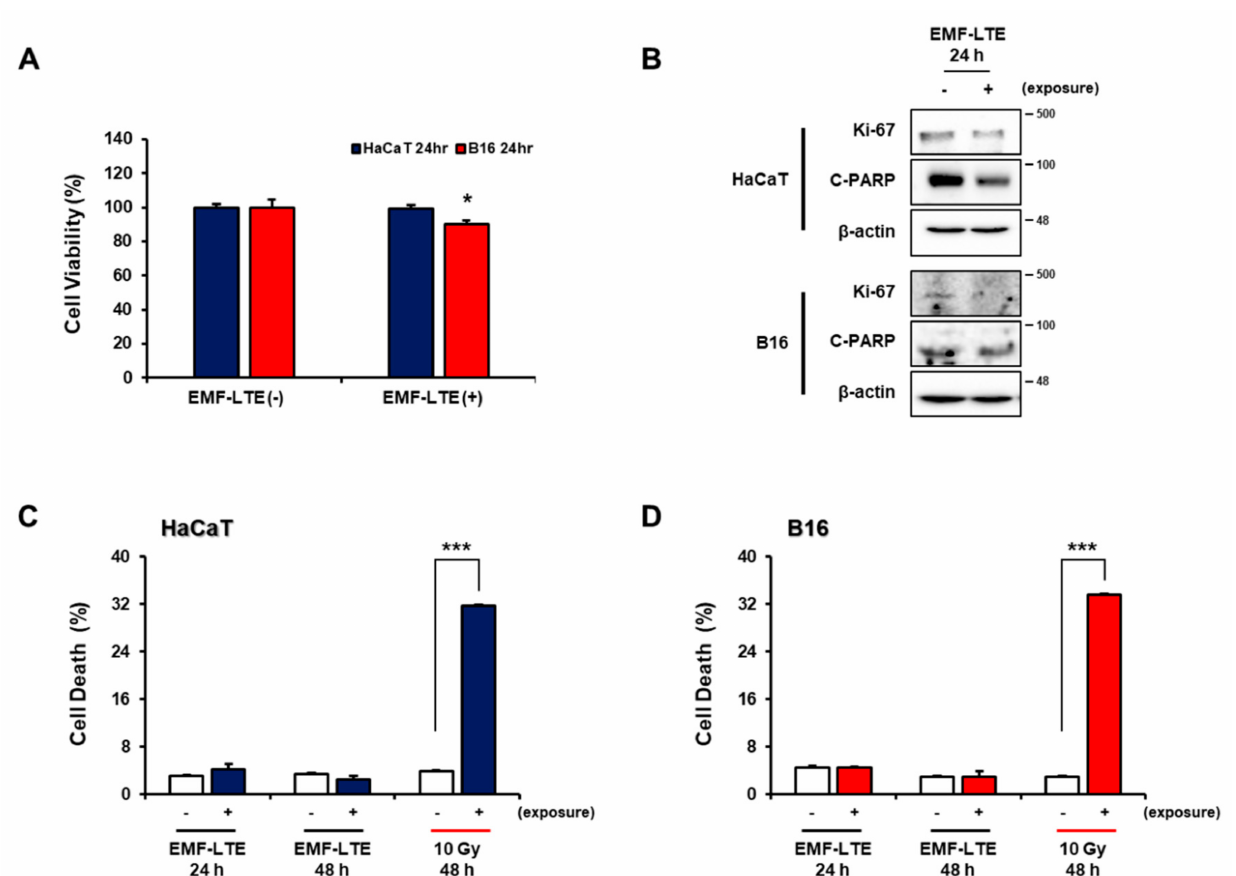
Figure 1. Effects of electromagnetic field-long term evolution (EMF-LTE) on cell viability, proliferation, and cell death of human keratinocyte cell line (HaCaT) and murine melanoma cell line (B16) cells. ( A ) MTT (3-(4,5-dimethylthiazol-2-yl)-2,5- diphenyltetrazolium bromide) assay in HaCaT cell and B16 cells was performed at 24 h after exposure to EMF-LTE. Each assay was performed in triplicate and in more than three independent experiments. * p < 0.05 vs. unexposed control ( t -test). ( B ) Cell proliferation (Ki67) and apoptosis (C-PARP; Cleaved Poly ADP-ribose Polymerase) markers were examined with Western blot analysis. Representative photos are presented. ( C ) HaCaT and ( D ) B16 cells were treated with the indicated dose of EMF-LTE. After the indicated time, the cells were harvested and analyzed with flow cytometry after PI (propidium iodide) staining. Each assay was performed in triplicate and in more than three independent experiments. *** p < 0.001 vs. unexposed control ( t